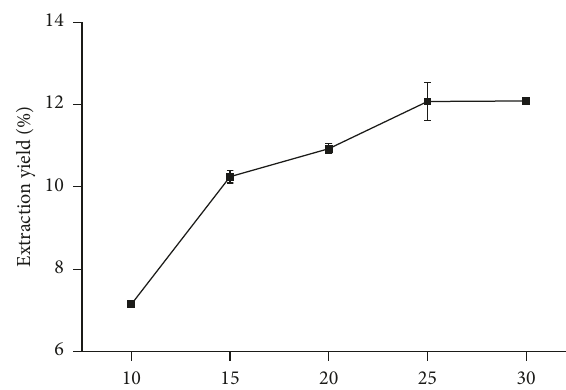
Figure 3: Extraction yield (%) of dried turmeric leaves in different solvent ratios. The moisture content of the turmeric leaf extract in different solvent ratio groups was measured to select the most acceptable extraction ratio for the further experiment. All exper- imental data were measured in triplicates. The optimum solvent ratio was 12.09% in 1 :25 extraction